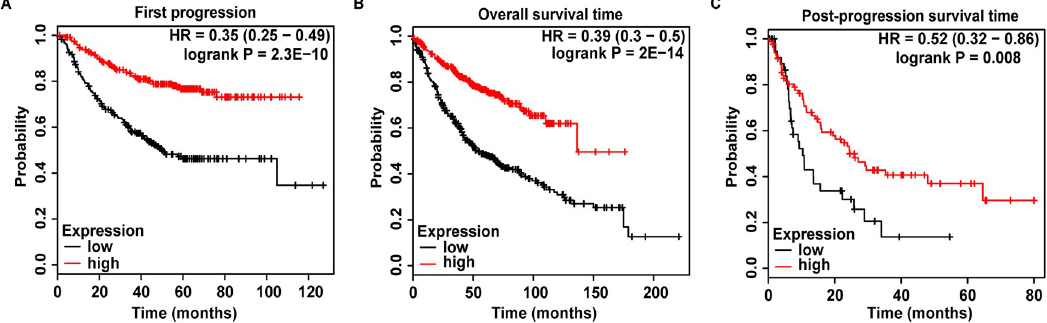
Fig 4. Analysis of ADARB1 expression on the prognosis of LUAD patients. (A-C) The relationship between ADARB1 expression and FS, OS or PPS, described by Kaplan-Meier Plotter, respectively.